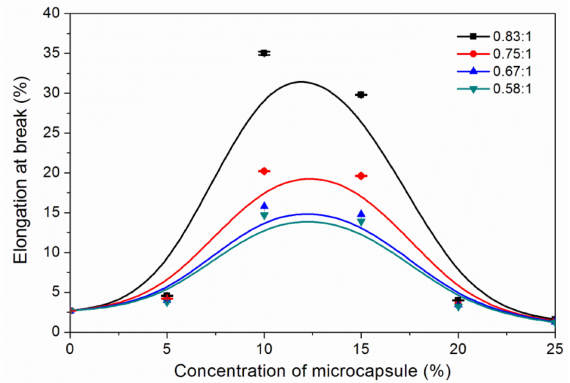
Figure 2. E ff ect of microcapsules with di ff erent core to wall mass ratios on elongation at break of